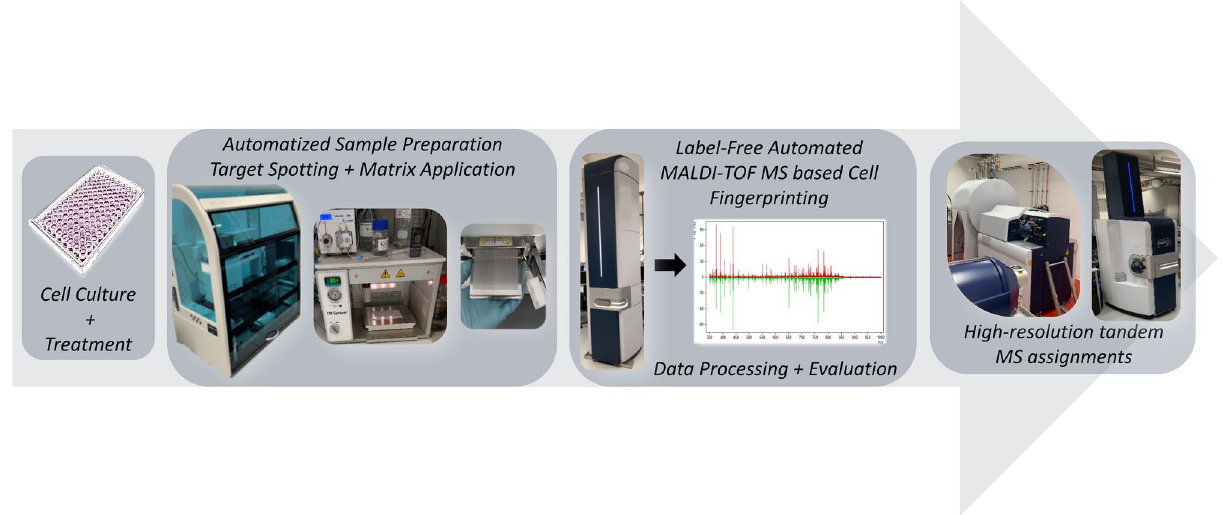
Figure 1. Workflow of MALDI MS microglia fingerprinting for investigation of lipopolysaccharide- (LPS-) driven changes in microglia lipids. Cultured cells are treated in 96-well format with LPS in combination with a compound or a solvent control. After removal of culture supernatants, 96-well plates are snap-frozen and stored at − 80 °C. Cells are resuspended in acetonitrile/water to 2000 cells/µl and 2 µl (corresponding to a total of 4,000 cells per spot) are spotted on a 384-well MALDI target plate in quadruplicate using a CyBio FeliX pipetting platform. DHB matrix is sprayed onto the target plate using an M3 sprayer. MS-spectra are acquired using a rapifleX MALDI-TOF mass spectrometer in automated fashion. Spectra are processed and computationally analyzed to reveal biomolecular patterns and putative markers. Ultra-high resolution mass spectrometry using a 7 T solarix XR MRMS, timsTOFfleX-MS and tandem MS are later used for identification of candidate marker lipids.